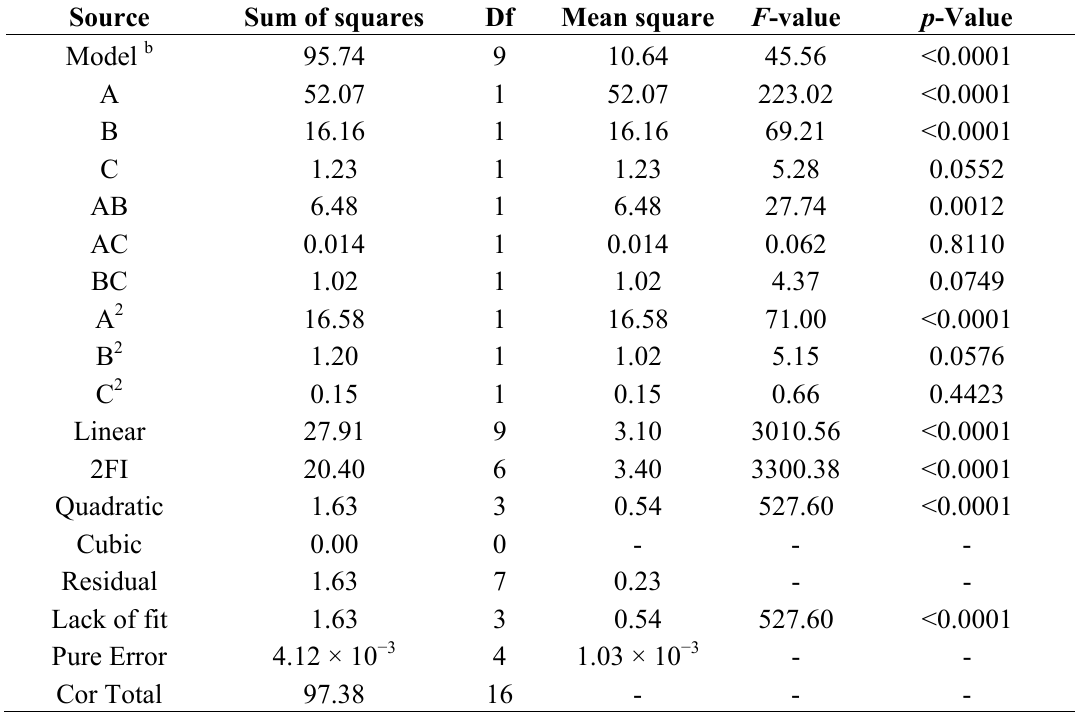
Table 2. Test of significance for regression coefficient a